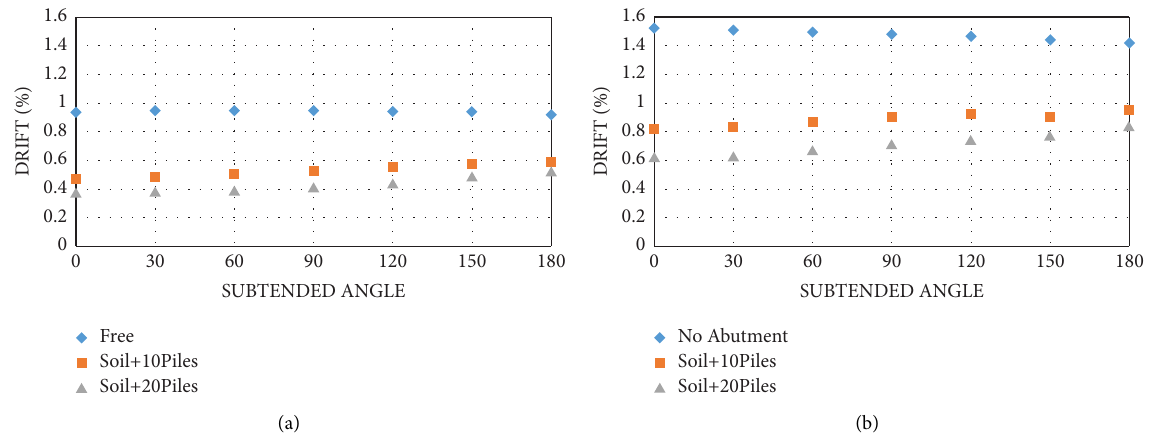
Figure 15: Drift demands of the middle column in all bridge confgurations in the tangential direction using GMs compatible to (a) DBE and (b) MCE response spectrums.